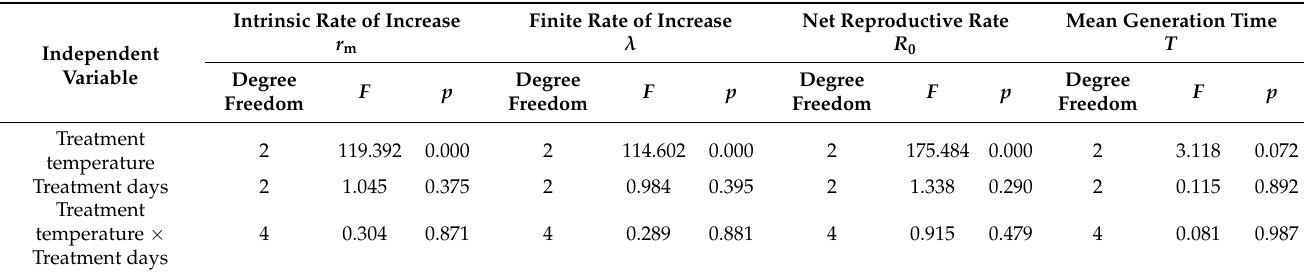
Table 5. Results of general linear model (GLM) for effects of treatment temperatures, treatment days and their interaction on demographic parameters of CPBs.